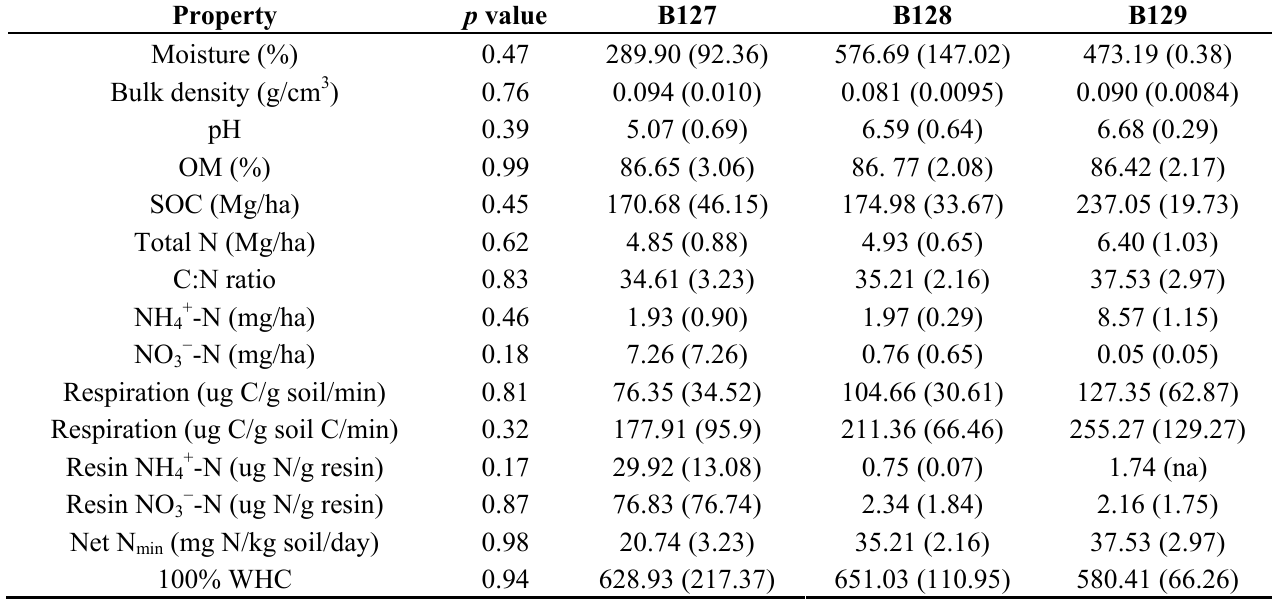
Table 4. Whole-profile organic ecosite property averages (standard